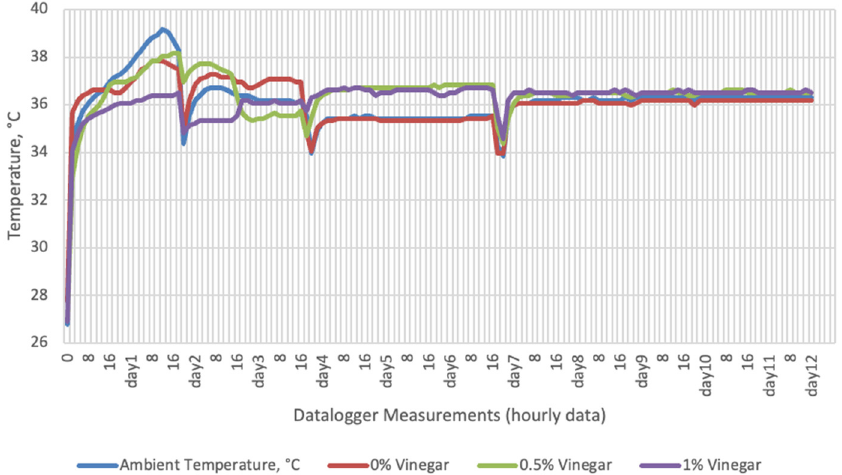
Figure 2. Temperature changes of apple vinegar supplemented groups stored at incubator conditions for 12 days (Ambient temperatures of incubator conditions: 35–37 °C; 26% Humidity).